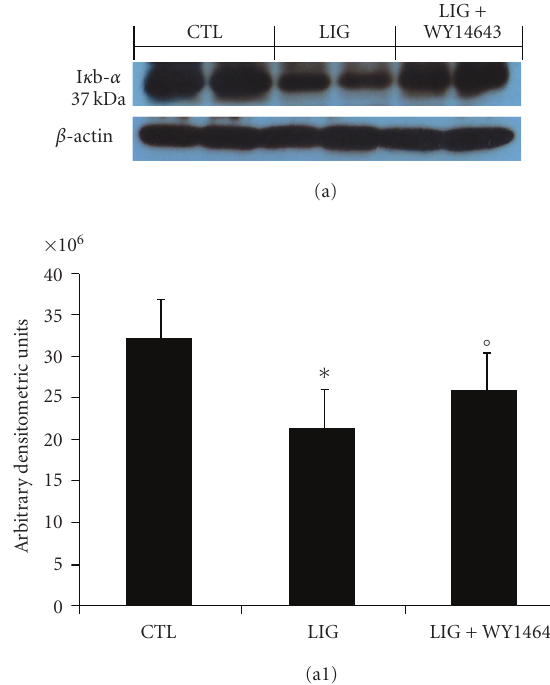
Figure 2: E ff ects of WY14643 treatment on NF- κ B activation in periodontitis. Representative Western blots showing the e ff ects of WY14643 on I κ B- α degradation (a, a1) in the gingivomucosal tissues from ligature-operated rats. A representative blot of lysates (a) obtained from 5 animals per group is shown and densitometry analysis of all animals is reported. The results in panel (a1) are expressed as mean ± s.e.m. from n = 5 / 6 gingivomucosal tissues for each group. ∗ P < . 01 versus nonligated. ◦ P < . 01 versus